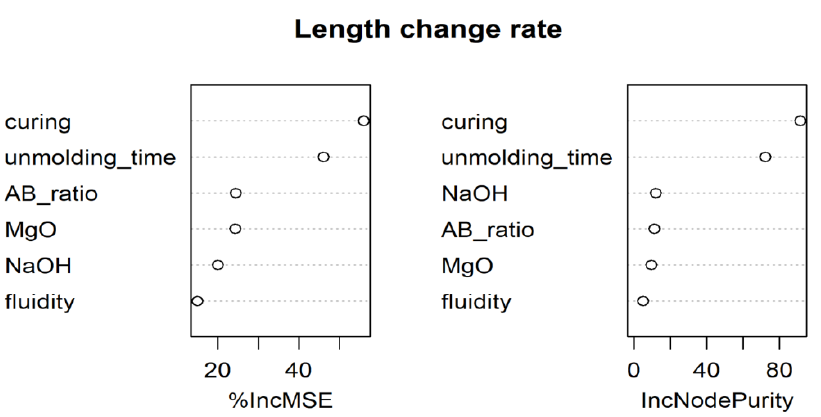
Figure 12. The most significant influencing factors on the length change ratio as determined by random